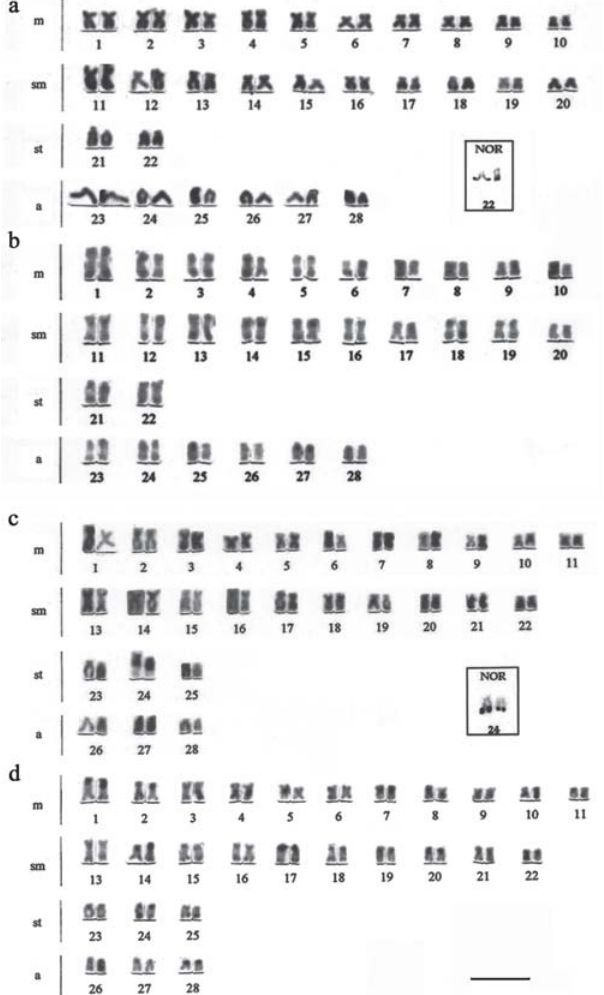
Fig. 1. Karyotype of Parapimelodus nigribarbis (a, b) and Pimelodus maculatus (c, d) with Giemsa (a, c) and C-banding (b, d). In the boxes the Ag-NOR-bearing pair of chromosomes. Scale bar = 10